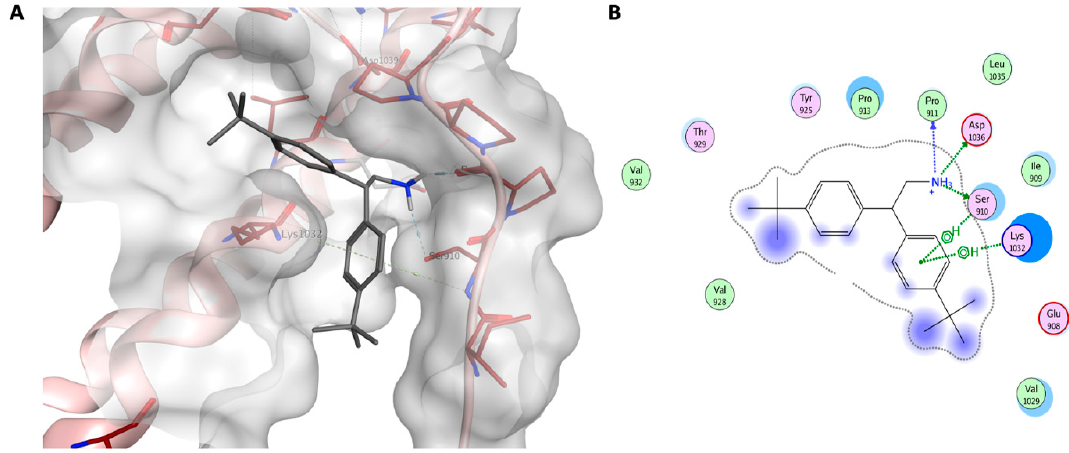
residues Ser 910, Thr 925, Thr 929, Pro 911, Pro 913, Lys 1032, and Asp 1036, as shown in Figure 5. Key interactions of compound 5f due to the presence of the free amine (NH 2 ) group include a salt bridge with the side chain carboxyl group (COOH) of Asp 1036, two H-bonds with the backbone carbonyl (C=O) group of Pro 911, and the side chain hydroxy group (OH) of Ser 910. In addition, hydrophobic interactions were noticed between the p-tert butyl phenyl moiety and the surrounding hydrophobic pocket formed of residues Tyr 925, Val 928, Val 932, Pro 913, and Leu 1035 (Figure 10).